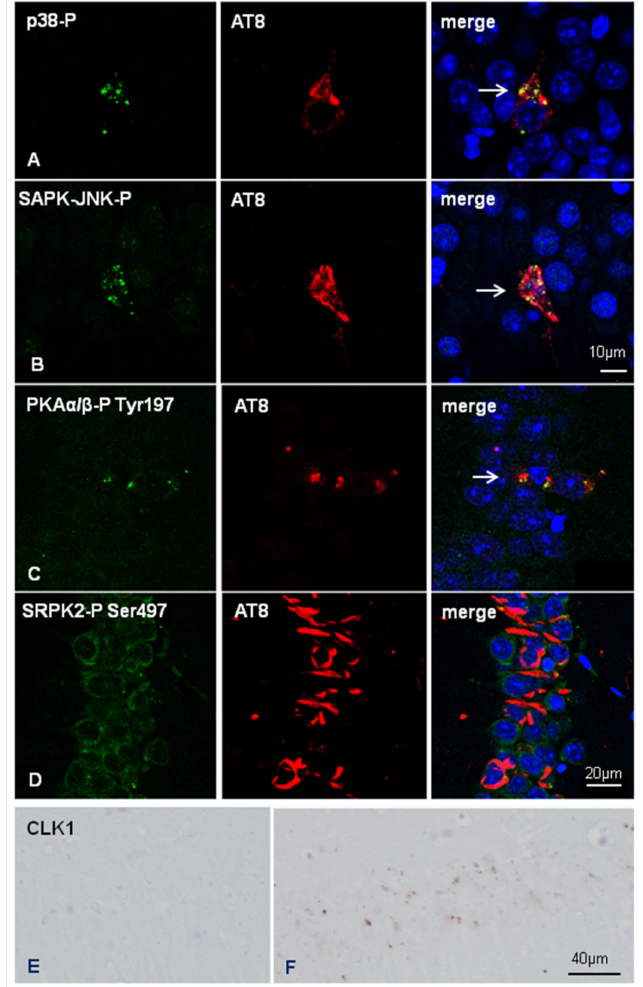
Figure 7. Double-labeling immunofluorescence and confocal microscopy to p38-P Thr180/Tyr182 or SAPK/JNK-PThr183/Thr185 (green), and AT8 (red) in inoculated hTau at the age of six months and killed at the age of nine months shows co-localization of the active kinases with phospho-tau deposition (white arrows) ( A and B , respectively for p38-P and SAPK-JNK-P) in dentate gyrus neurons. Double-labelling immunofluorescence and confocal microscopy to PKA α / β -P Tyr197 and AT8 in inoculated hTau mice shows cytoplasmic granular PKA α / β -P Tyr197 granules in CA1 neurons with abnormal phospho-tau deposits in neurons ( C , arrow). Cytoplasmic SRPK2-Ser497 immunoreactivity is found in neurons with phospho-tau deposits in inoculated hTau mice ( D ). Paraffin sections, nuclei are stained with DRAQ5™ (blue), A, B, bar = 10 µ m, C and D, bar = 20 µ m. CLK1 immunoreactivity in the CA1 region of non-inoculated ( E ) and inoculated hTau with AD sarkosyl-insoluble fractions ( F ); small cytoplasmic granules are seen in inoculated hTau. Paraffin sections, slightly counterstained with haematoxylin, bar = 40 µ